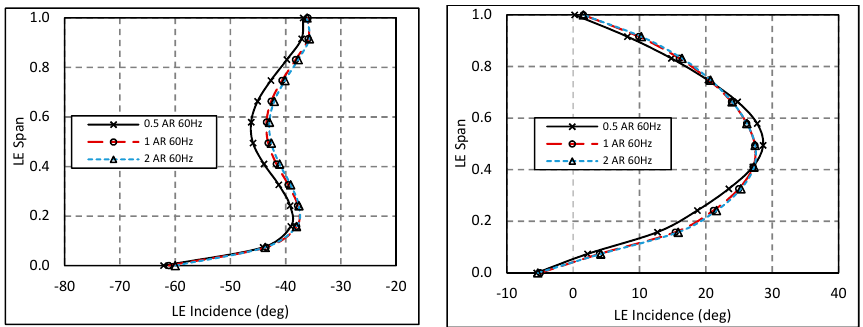
Figure 23. LE incidence at 60 Hz frequency. ( Left ) Minimum incidence running point; ( Right ) Maximum incidence running point.